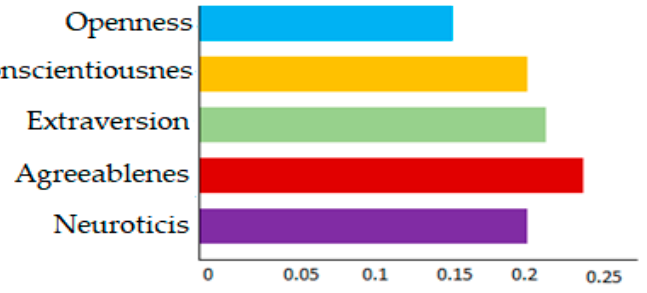
Figure 7. Distribution of personalities of all users of the dataset results in relative differences between the percentage of one personality and another.